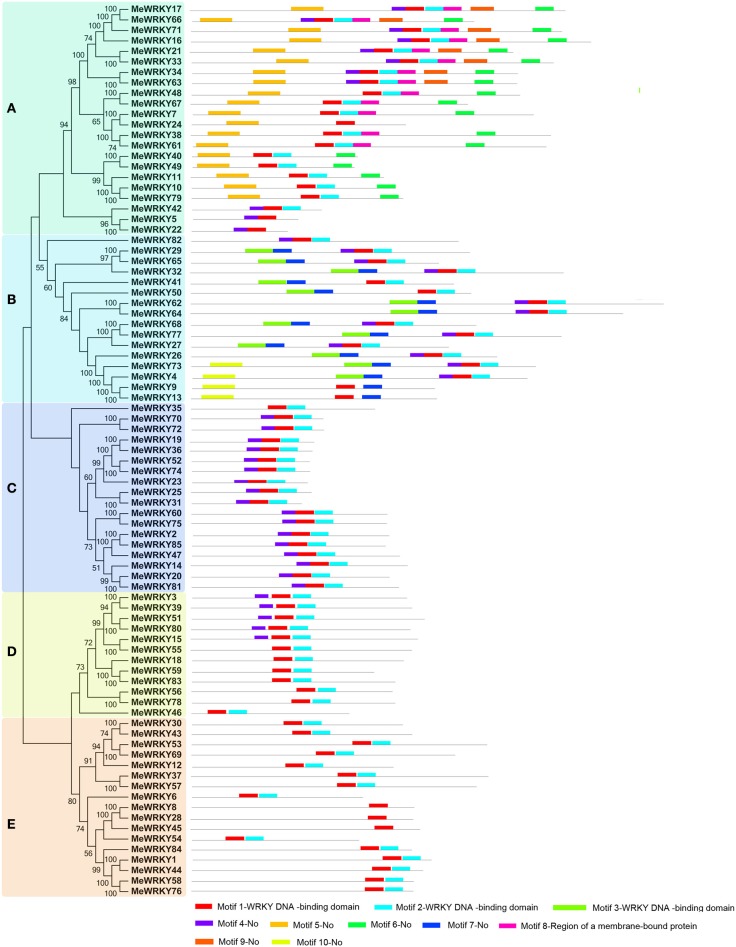
Conserved motifs of MeWRKY proteins according to the phylogenetic relationship. The NJ tree was constructed with full amino acids of cassava WRKYs using ClustalX 2.0 and MEGA5 with 1000 bootstraps. The conserved motifs in the MeWRKY proteins were identified by MEME. Gray lines represent the non-conserved sequences, and each motif is indicated by a colored box numbered at the bottom. The length of motifs in each protein was exhibited proportionally. (A–E) indicates different groups of WRKY family in cassava.